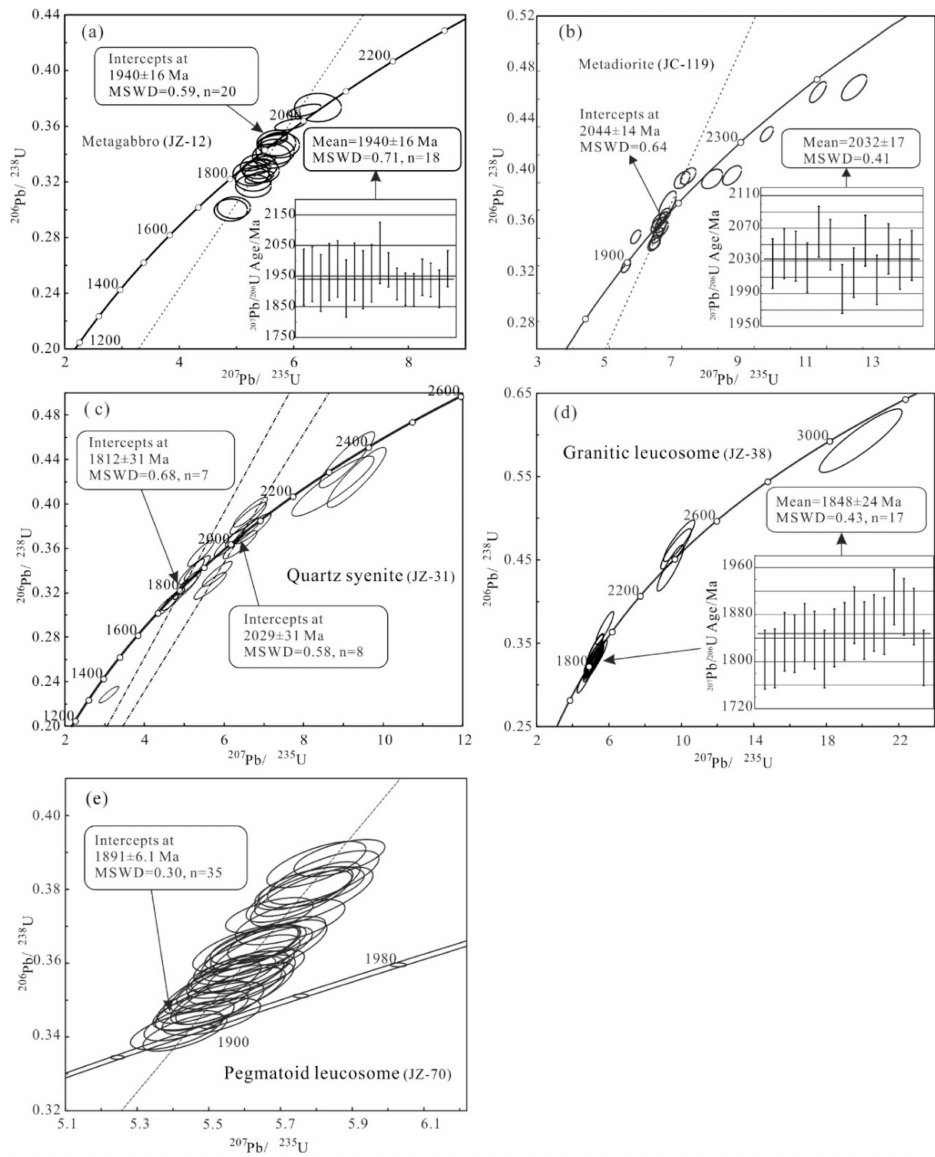
Figure 8. Concordia diagrams for zircon LA-ICPMS U–Pb analyses. ( a ) Metagabbro sample JZ-12; ( b ) metadiorite sample JC-119; ( c ) quartz syenite sample JZ-31; ( d ) granitic leucosome sample JZ-38; ( e ) pegmatoid leucosome sample